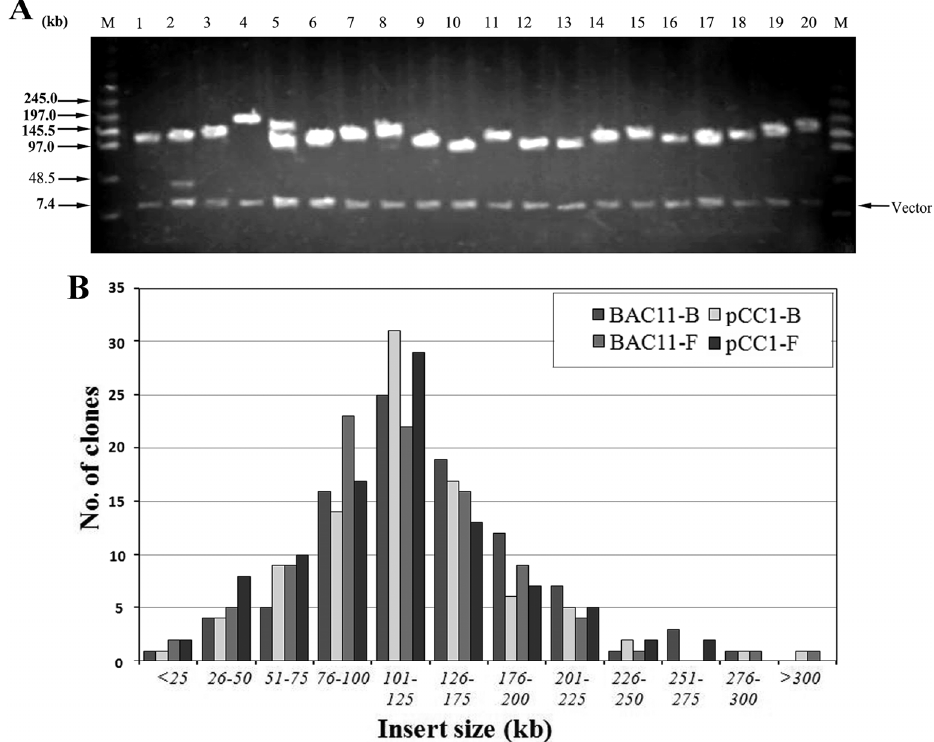
Figure 3. Characterization and Insert size testing of Siberian tiger BAC